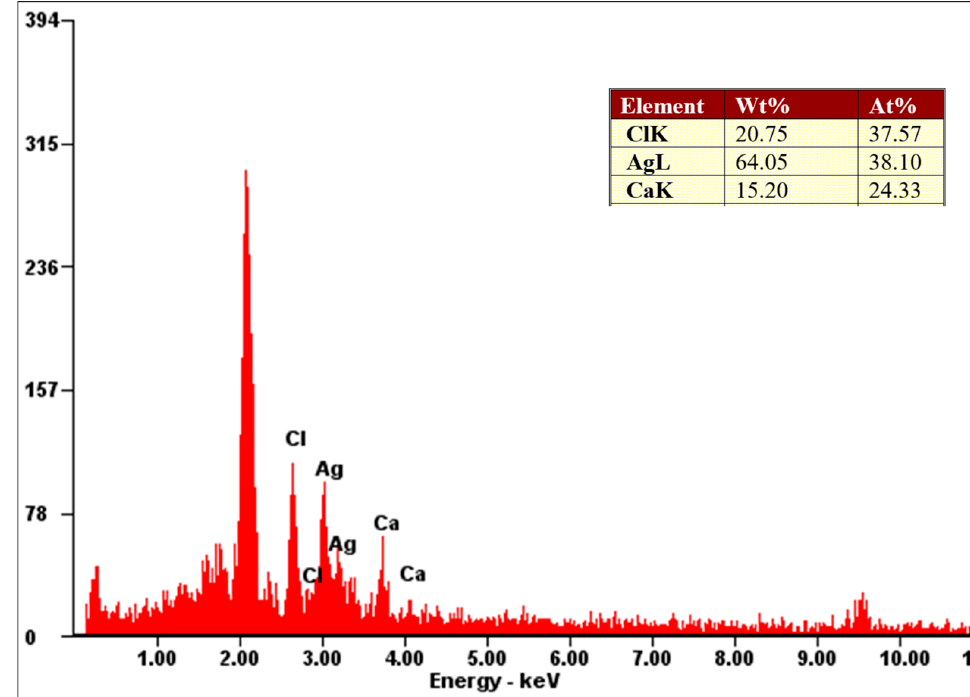
Figure 4. EDX spectrum of synthesized AgNPs.